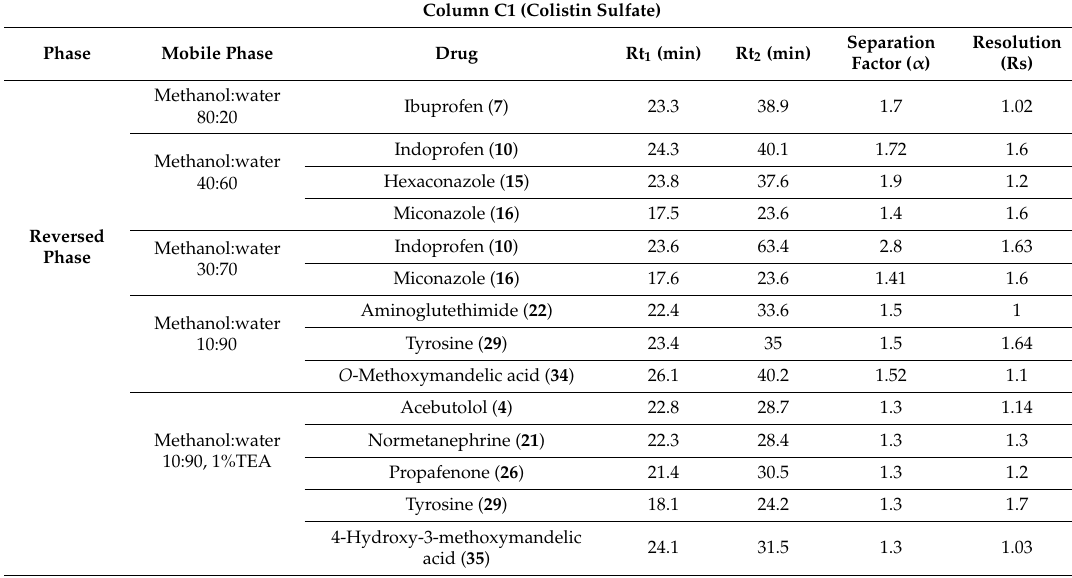
Table 1. Chromatographic data, separation and resolution factors for the significantly resolved compounds, using reversed mobile phases, flow rate: 1 µ